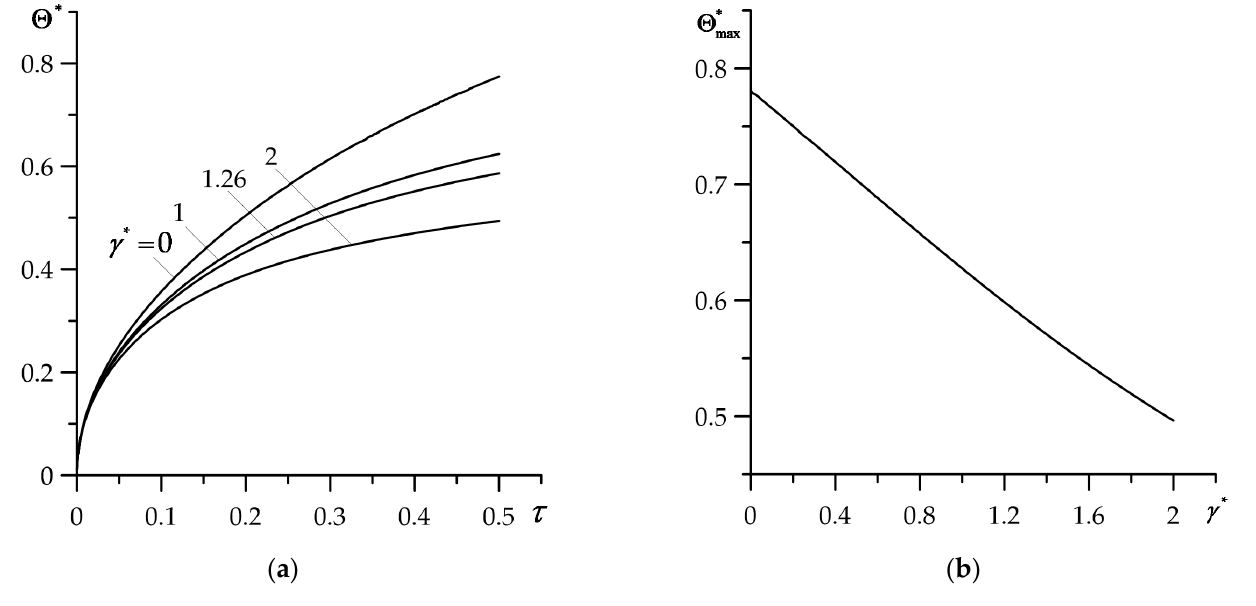
Figure 5. Effect of FGC gradient γ ∗ on dimensionless temperature rise: ( a ) evolution Θ ∗ ( 0, τ ) (68), (69) for selected values of γ ∗ , ( b ) dependency Θ ∗ max ≡ Θ ∗ ( 0, 0.5 ) on γ ∗ . Investigation of the impact of linearly decreasing time profile of the heat flux intensity (103) was carried out based on solutions (113) and (114) for τ s = 0.5, γ ∗ = 1.26 (Figure 6). For a constant intensity of the heat flux, the temperature of the coating and substrate increases monotonically with the heating time (Figure 3). However, in the considered case of a linear heat flux intensity profile, the temperature of the coating reaches its maximum ∗ value ˆ Θ at the moment of time 0 < τ max < τ s , and then decreases (Figure 6a). The max ∗ maximum temperature value ˆ Θ is achieved the earliest on the FGC outer surface ζ = 0. max ∗ The time to reach ˆ Θ increases with the distance from heated surface. max